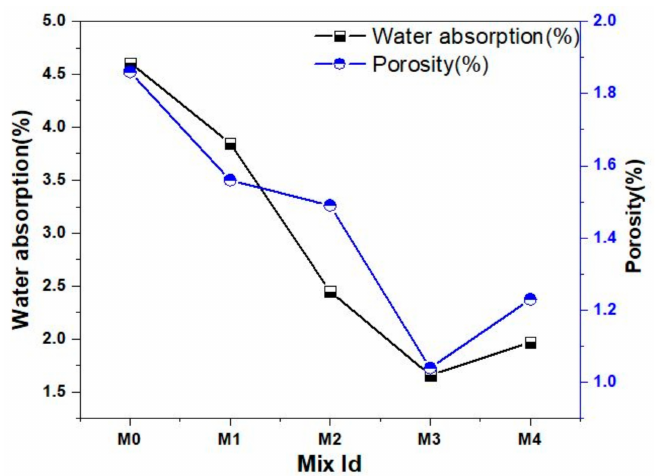
Figure 12. Water absorption and porosity of various concrete mixes.